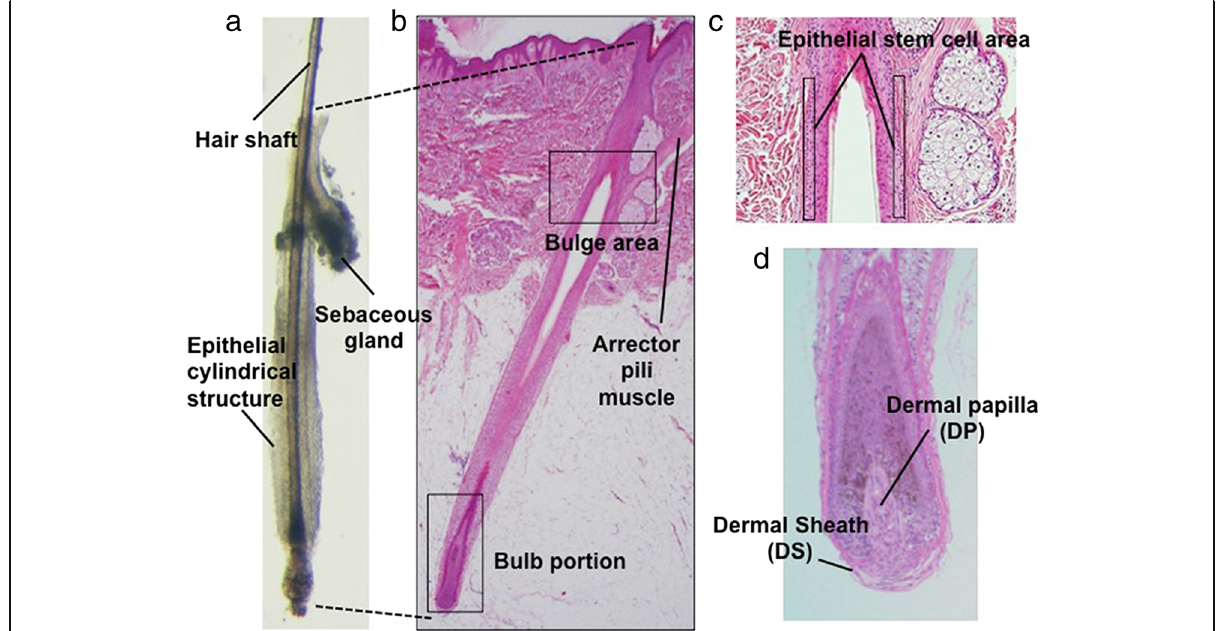
Fig. 1 Normal human scalp hair follicle structure. a A hair follicle microdissected from human scalp (an anagen hair follicle is presented). b Corresponding histopathology image. The bulge area harbors stem cells. Hair matrix cell proliferation in the bulb results in hair shaft elongation. c Hair follicle epithelial stem cells locate in the outermost layer of the outer root sheath. d The dermal papilla (DP) and the dermal sheath (DS) are mesenchymal components demonstrate trichogenic